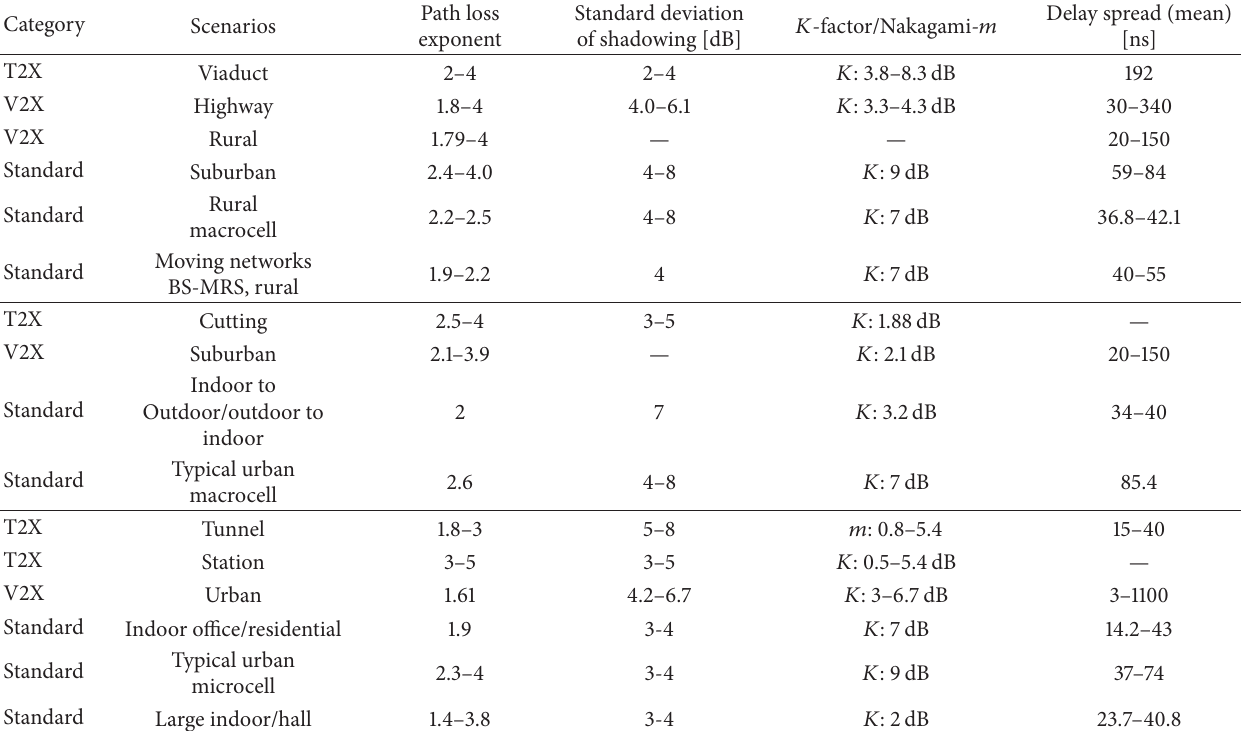
Table 1: Channel characteristics of T2X, V2X, and standard